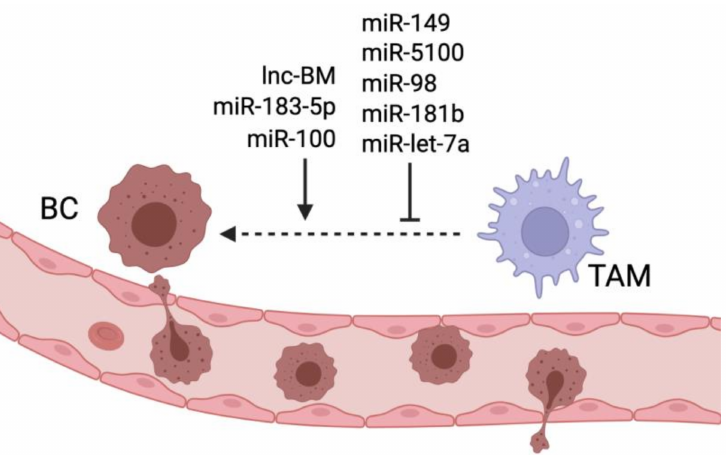
Figure 3. miRNAs and lncRNAs regulating TAM-induced breast cancer metastasis. Lnc-BM, miR-183- 5p, and miR-100 promote TAM ability to stimulate breast cancer metastasis, while miR-149, miR-5100, miR-98, miR-181b and let-7a inhibit TAM- mediated metastasis